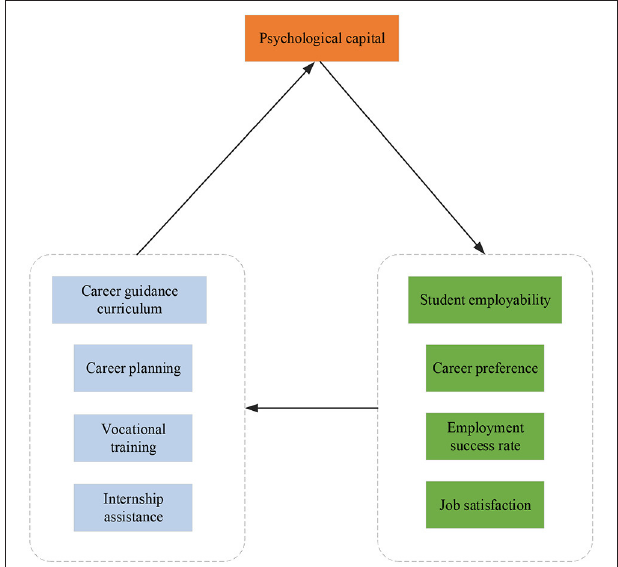
FIGURE 3 | Key variable research